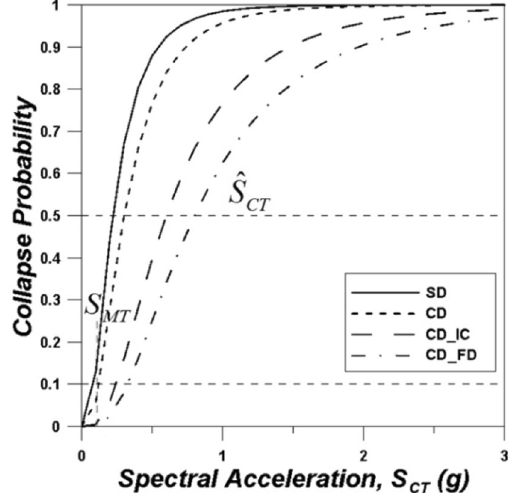
Fig. 27 Fragility curves of the structures designed using R = 5 for reaching dynamic